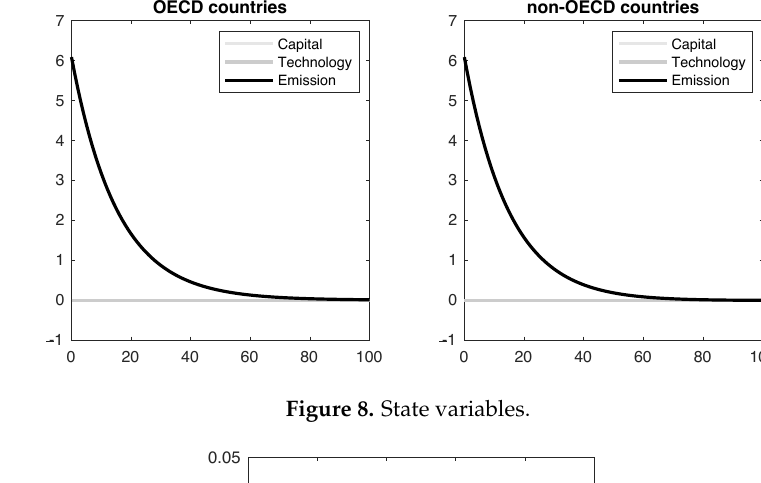
Figure 8. State variables.